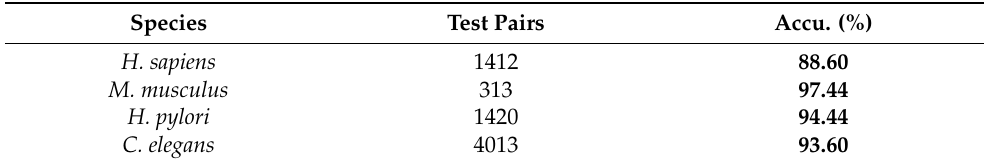
Table 7. Prediction results were obtained on four independent